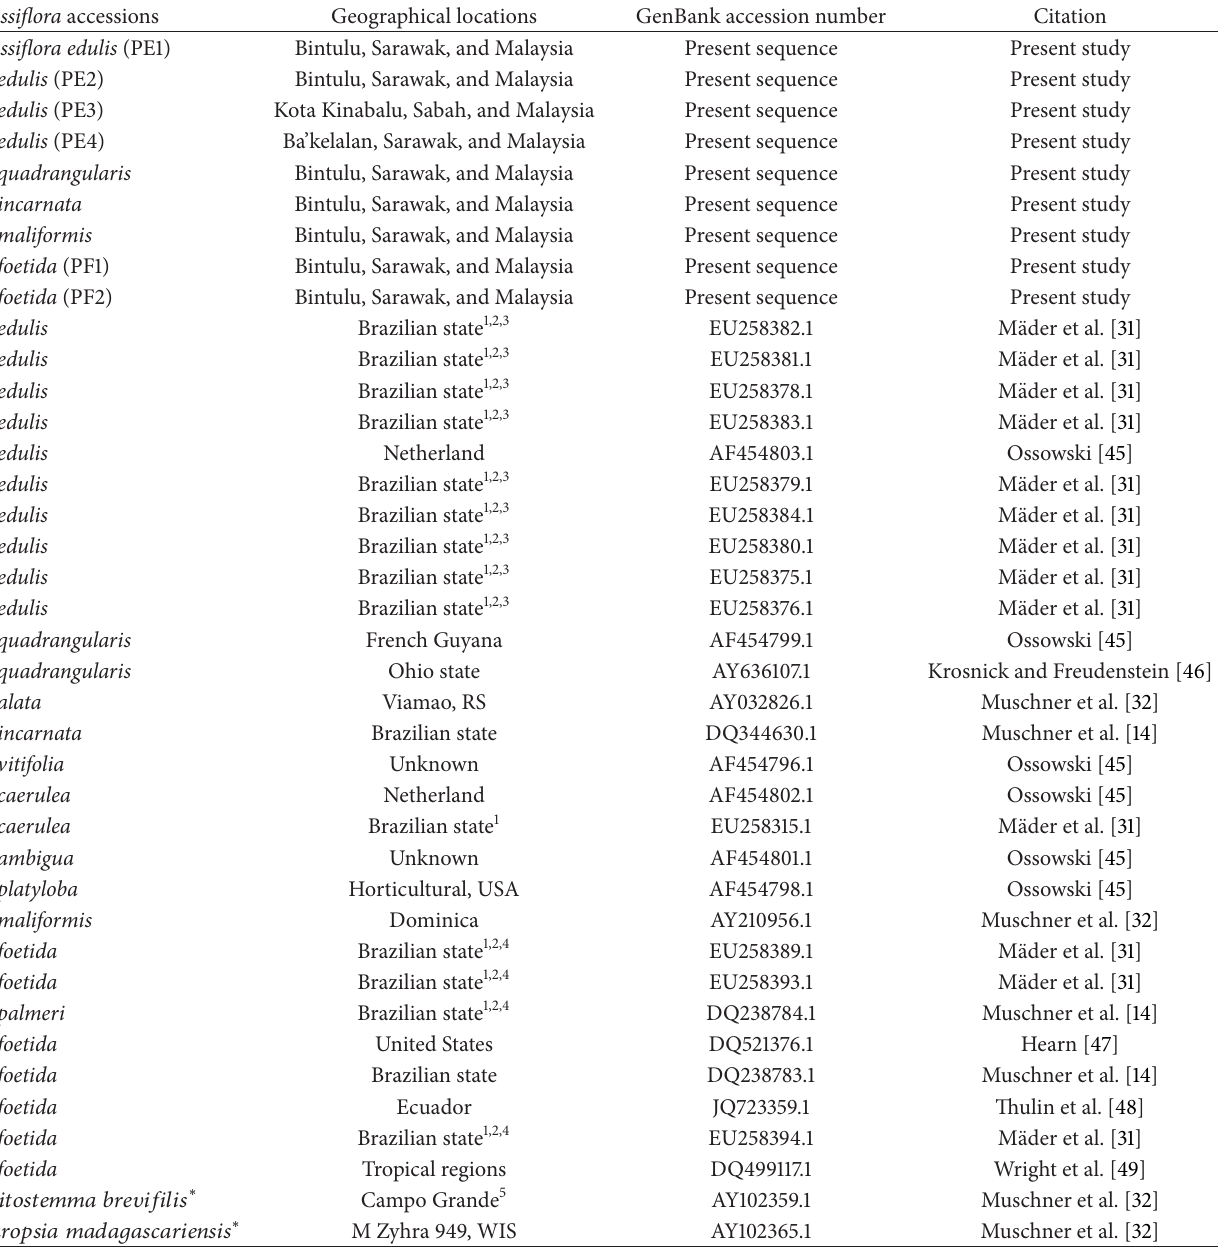
Table 1: List of Passiflora accessions examined and individuals included in molecular analysis with their geographical locations, GenBank accession numbers, and references.